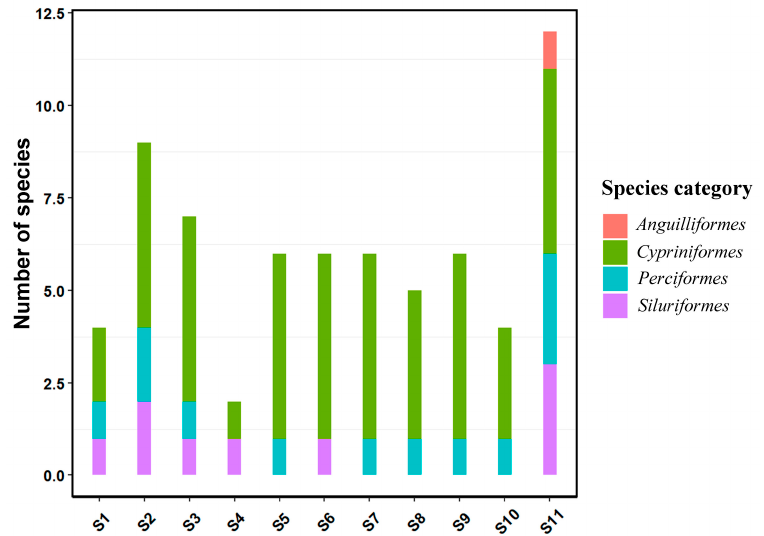
Figure 5. Distribution of fish species at sampling sites.